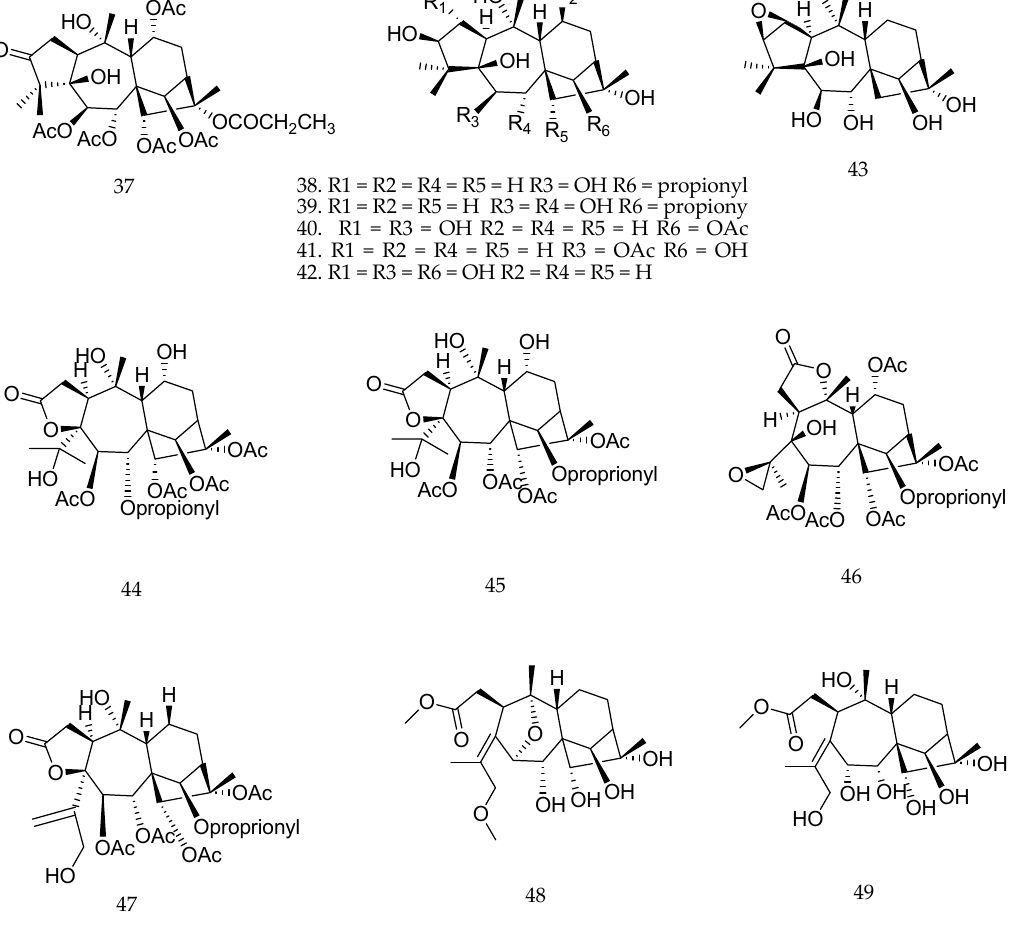
Figure 22. Chemical structures of diterpenes 37 – 49 [103].